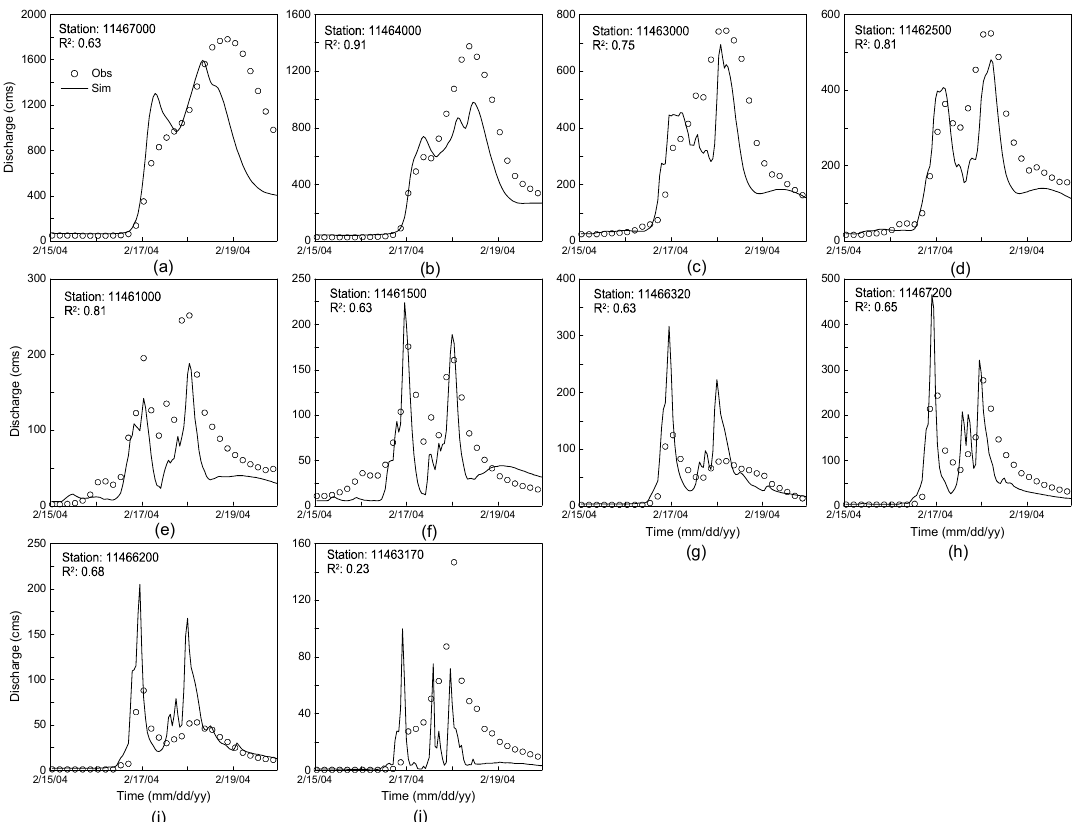
Figure 5. Comparison of hourly observed (USGS) and simulated (NWM) streamflow data at the ten stations (15–18 February 2004). The line means the simulated streamflow by the NWM, and the dot means the observed streamflow at each station. ( a – j ) are ten stations in the Russian River basin listed in Table 2.